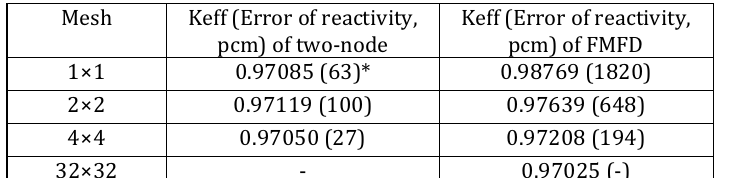
Table II. Keff Comparison of KAIST 3A Benchmark Problem